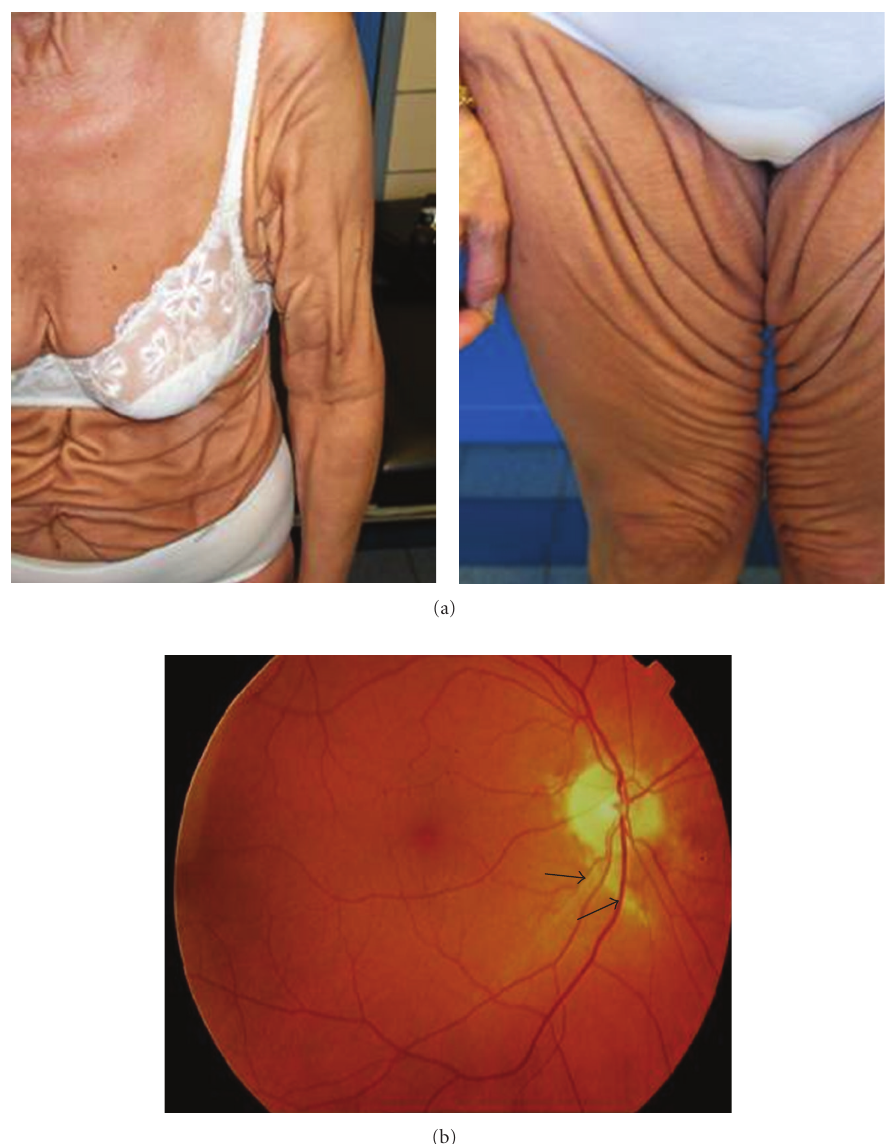
Figure 4: Clinical symptoms of the PXE-like syndrome. Severe cutis laxa-like skin folds beyond the flexural areas (a). A mild retinopathy with minimal angioid streaks (b,